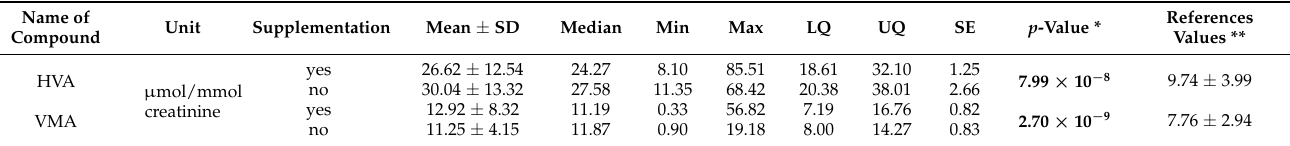
Table 1. Stratification of tested population (mean ± SD).